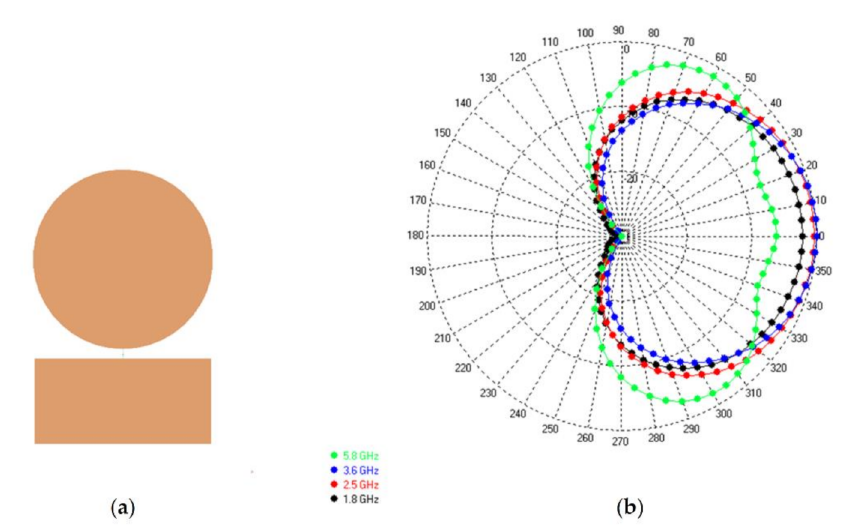
Figure 10. Single circle antenna optimized with Pareto Estra algorithm: ( a )—antenna geometry. ( b )—radiation pattern in x-z plane for on-body position.